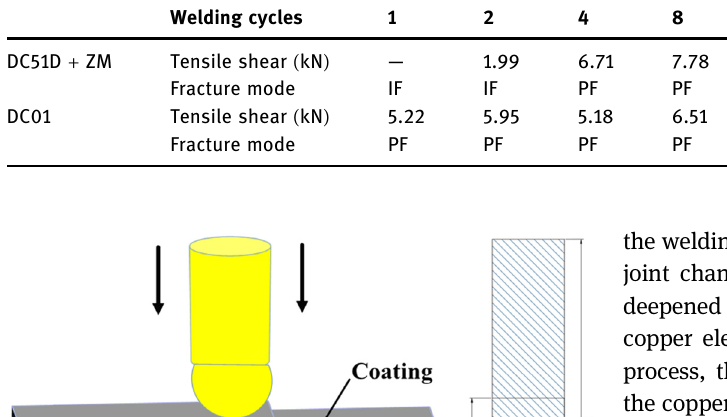
Table 2: Chemical composition and mechanical properties of DC51D + Zm and DC01 Welding cycles